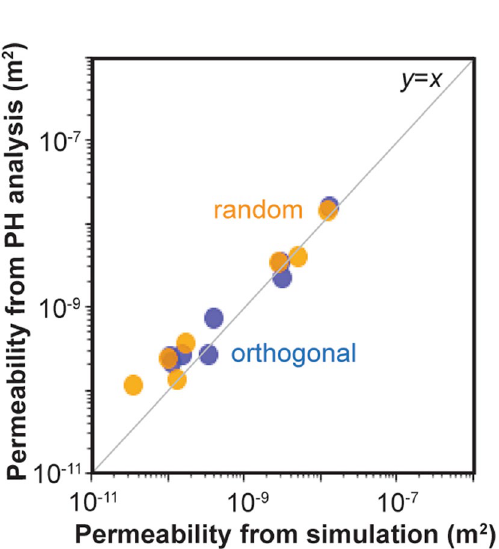
Table 2. Estimation for simple parallel model. The correlation coefficient between simulation results and PH estimation was 0.9996.